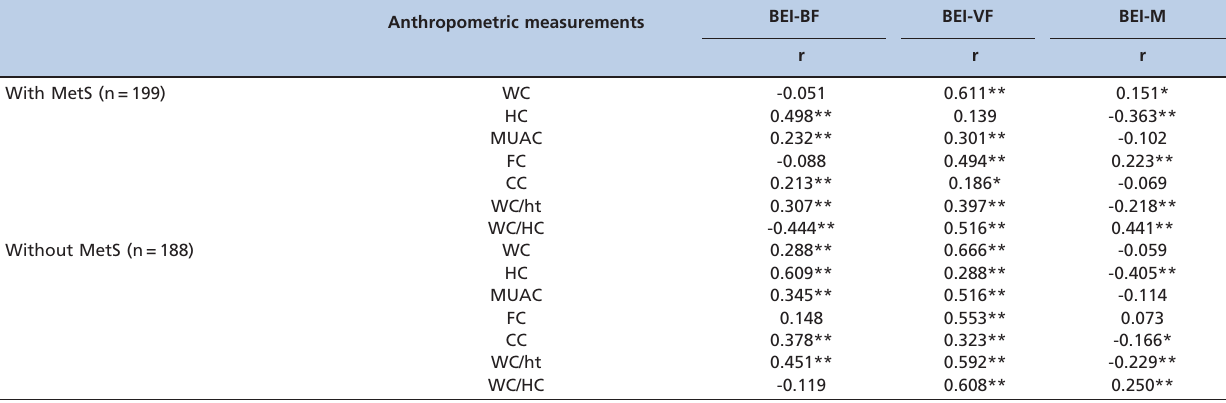
Table 2 - Pearson’s correlation coefficients between anthropometric measurements and body composition in subjects with and without MetS.